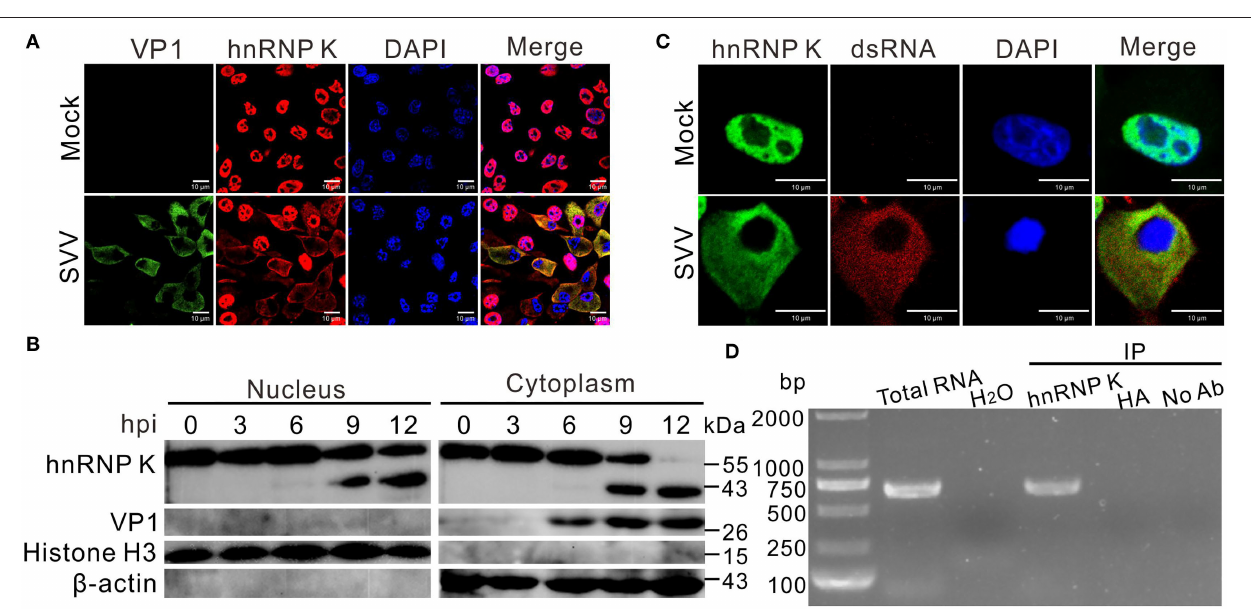
FIGURE 2 | SVV infection induces relocalization of hnRNP K. (A) BHK-21 cells were infected with SVV (MOI = 5), at 0 and 12 hpi, cells were stained with antibodies against hnRNP K (red), VP1 monoclonal antibody (green), and DAPI (blue), captured under confocal microscopy. (B) SVV-infected (MOI = 5). BHK-21 cells were collected at 0, 3, 6, 9, and 12 hpi, cytoplasmic and nuclear fractions were extracted and subjected to Western blotting with antibodies against hnRNP K, VP1, histone H3, and β -actin. (C) BHK-21 cells were infected with SVV (MOI = 5), at 0 and 12 hpi, cells were stained with antibodies against hnRNP K (green), dsRNA monoclonal antibody (red), and DAPI (blue), captured under confocal microscopy. (D) SVV 5 ′ UTR RNA was pulled down with hnRNP K from SVV-infected (MOI = 5) cell lysate. BHK-21 cells were infected with SVV for 12h, the harvested cell lysates were immunoprecipitated with rabbit anti-hnRNP K, rabbit anti-HA, and without antibodies, then subjected to RT-PCR. SVV-infected cells and H 2 O used as a positive control and negative control for RT-PCR using SVV 5 ′ UTR specific primers,